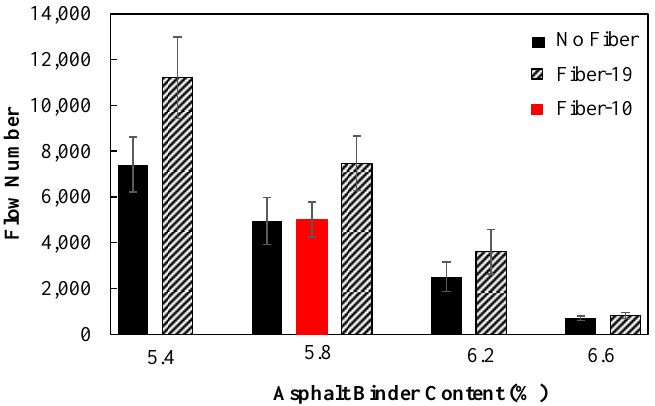
Figure 6. Flow numbers for mixtures with and without fibers at different asphalt contents.